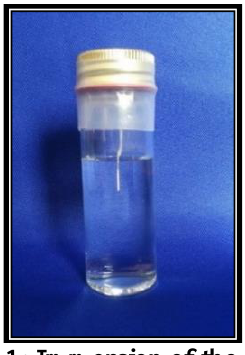
Figure 1: Immersion of the sample in the artificial saliva.